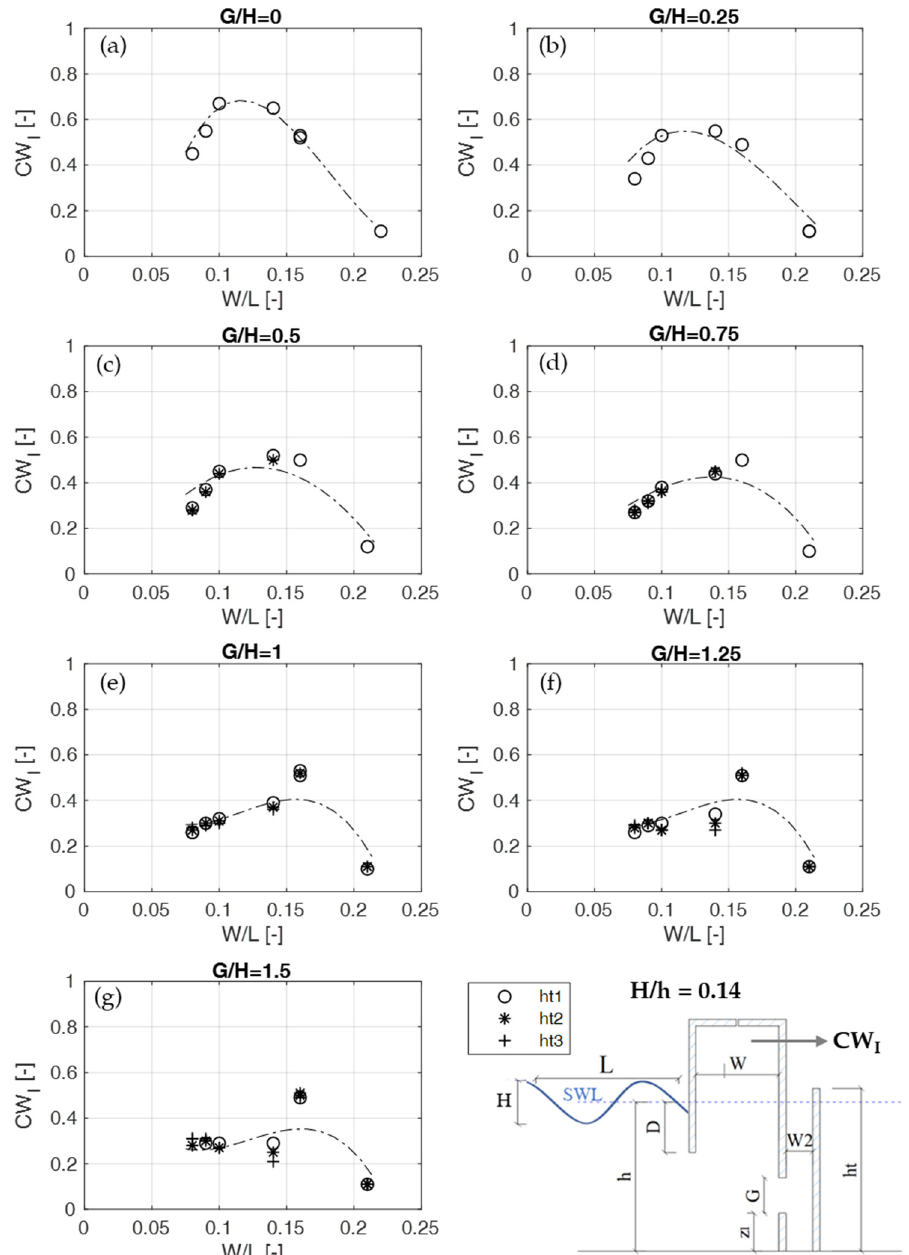
Figure 7. Capture width of the OWC chamber CW I as a function of the relative width of the OWC chamber, W / L , for different sizes of the aperture in the back wall relative to the water depth h : G / H = 0 ( a ), 0.25 ( b ), 0.5 ( c ), 0.75 ( d ), 1 ( e ), 1.25 ( f ), 1.5 ( g ). Results are obtained for H / h = 0.14.